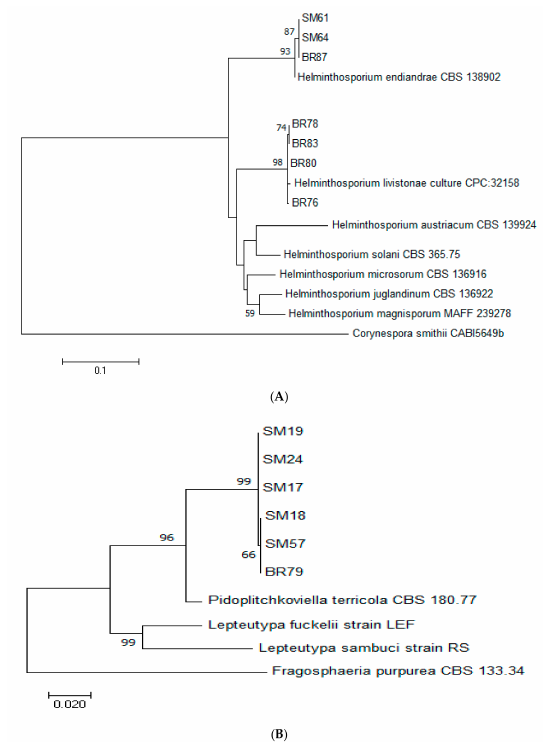
Figure 6. Maximum likelihood tree inferred from combined sequences of ITS and LSU for ( A ) Helminthosporium spp. and ( B ) Pidoplitchkoviella terricola from C. castaneus spines with boot- strap values higher than 50% are shown next to the